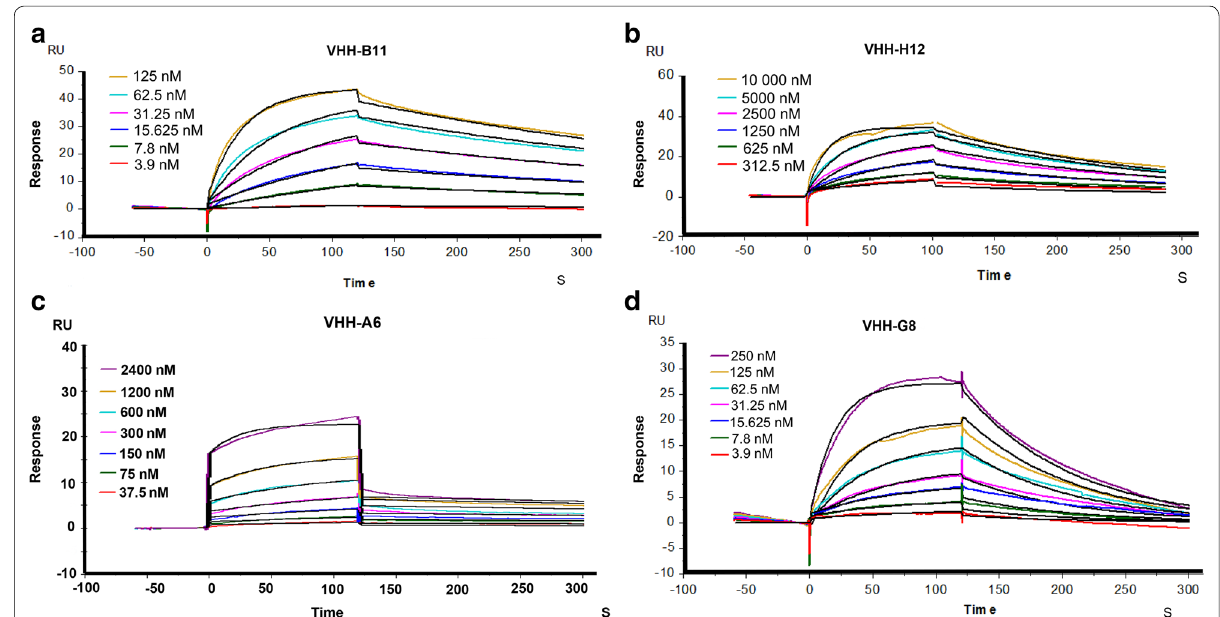
Fig. 3 The affinity test for the four VHHs/hPCSK9 interaction. A 6 or 7-points, double fold dilution of these VHH-based proteins were injected to bind with the hPCSK9. Each colored line represents one concentration of the VHH proteins. The black lines represent the automatic fitting curves by the built-in evaluation software. The horizontal axis represents the timeline, and the vertical axis represents the relative response unit of the VHH/ hPCSK9 interaction. The VHH protein injection time point was automatically set as 0 s by the built-in evaluation software